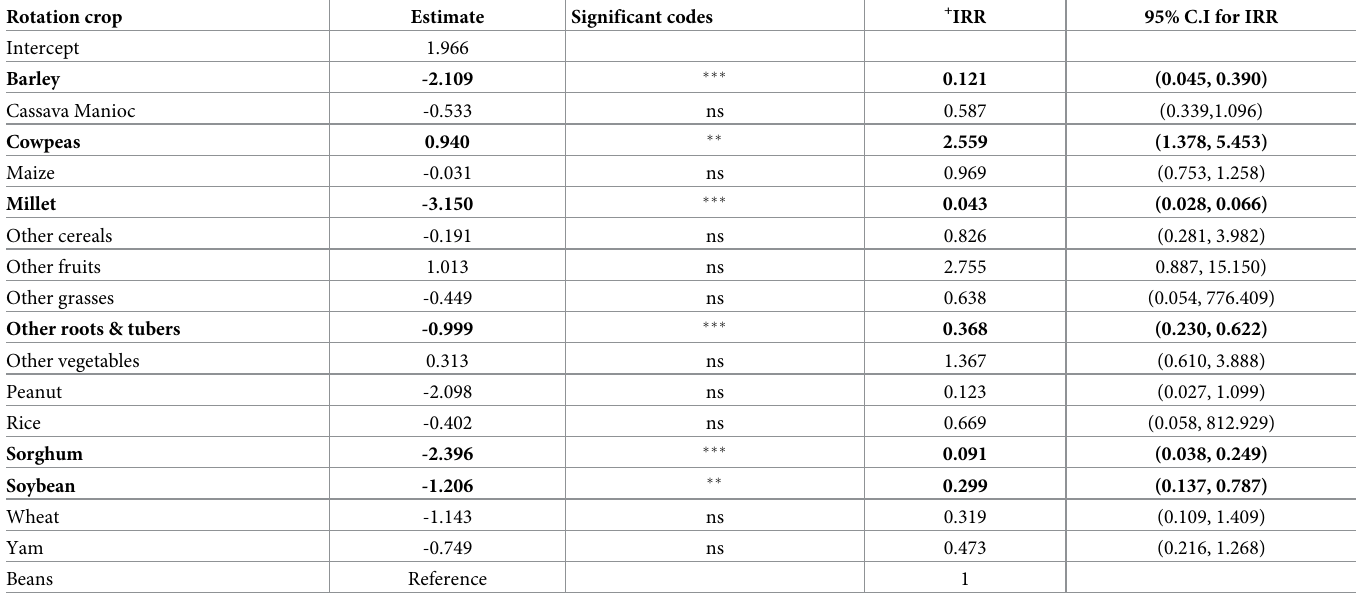
thuringiensis (Bt), Metarhizium , Beauveria and spinosad. Metarhizium anisopliae was the most commonly used biopesticide in the region, except in Burundi, where NPV was used. Table 3. Regression parameter estimates and incident rate ratios (IRR) estimated from the negative binomial model on trap counts for the rotation crop factor adjusted for crop phenology with beans crop was used as a reference level ϯ . Rotation